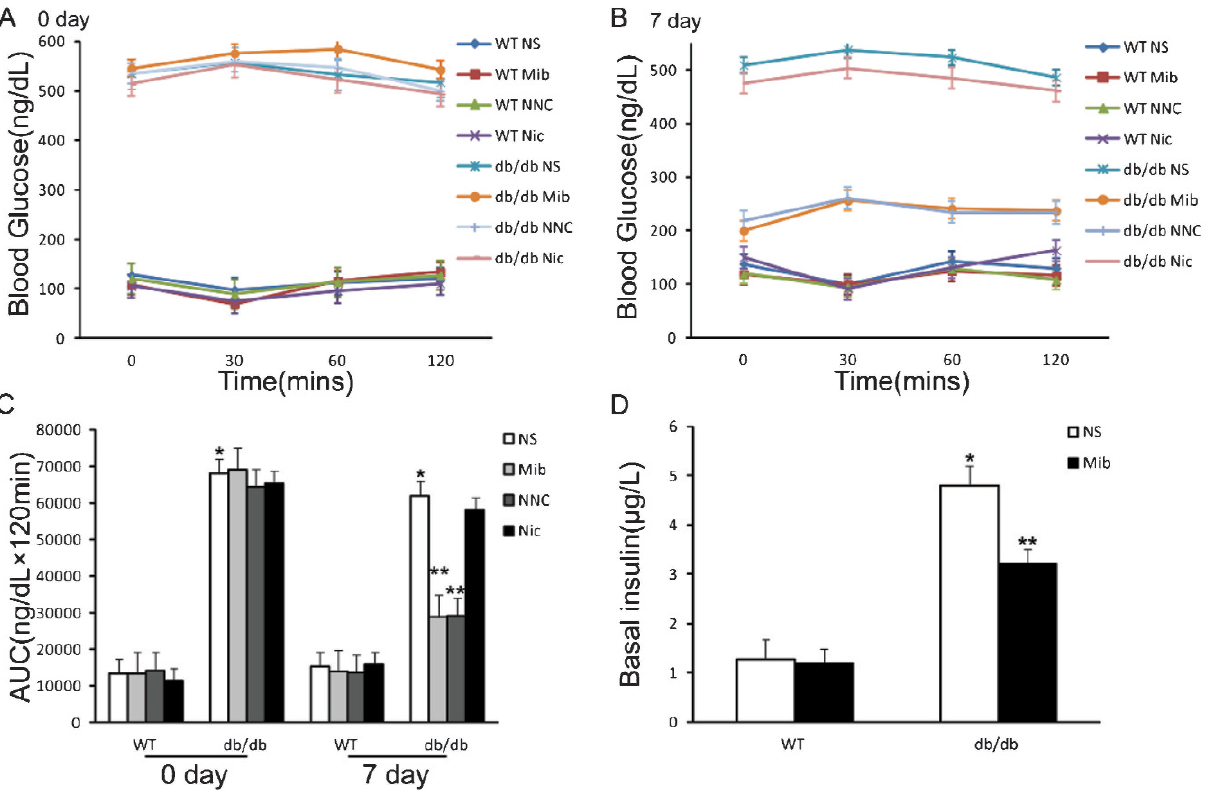
Figure 3 - Effects of mibefradil on insulin sensitivity and basal insulin release in diabetic and nondiabetic mice. A and B) Glucose disposal measured by insulin tolerance test (ITT) before (A) and after (B) mibefradil treatment for seven days. C) Difference in the area under the curve before and after drug injection. D) Effect of mibefradil on basal insulin in diabetic and nondiabetic mice. * p , 0.05, n=6, compared with WT NS group; ** p , 0.05, n=6, compared with NS group of the same type of mice at the same time. Statistical analyses were performed with Student’s t-test (D) or ANOVA (C), according to the specific